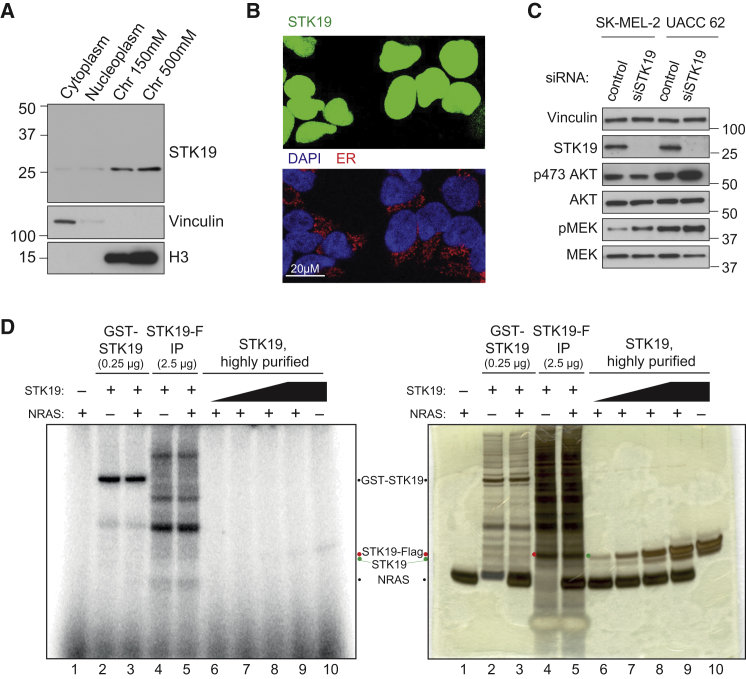
Evidence That STK19 Is Chromatin-Associated and That It Binds DNA(A) STK19 western blot analysis after sub-cellular fractionation. “Chromatin 150 mM” and “Chromatin 500 mM” contain proteins extracted from the chromatin using 150 mM or 500 mM NaCl, respectively. Vinculin and histone H3 (H3) are used as markers for predominantly cytoplasmic and chromatin localization, respectively.(B) Detection of STK19-flag-GFP (green) by microscopy. Image is overexposed to enable detection of any possible GFP specific signal outside the nucleus. DAPI-stained nuclei (blue) and ER calnexin (red) are shown as controls.(C) Western blot analysis of AKT and MEK phosphorylation (p473 AKT and p217/221 MEK) before and after STK19 knockdown and their respective unphosphorylated controls. Vinculin is used as control. Please note that the blot-strip depicting STK19 and the loading control, vinculin, are repeated from Figure 2D, as these came from the same experiment.(D) STK19 kinase reactions, utilizing the conditions used by Yin et al., 2019, with highly purified NRAS protein as the substrate. STK19-FLAG (STK19-F) was isolated from cells using the procedures described by Yin et al., while GST-STK19 was purchased from SignalChem. The autoradiograph on the left was generated by exposure of the silver-stained gel on the right. The migration of relevant proteins is indicated between the images. Note the many proteins co-immunoprecipitating with STK19 using Yin et al.’s conditions (lanes 4–5).